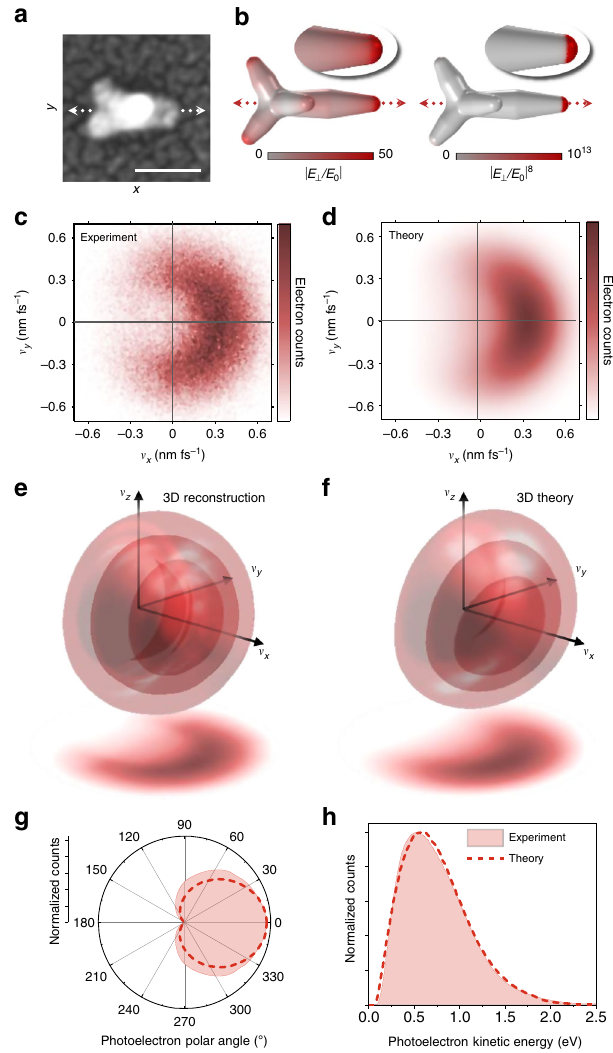
Fig. 2 Characterization of single-tip multiphoton